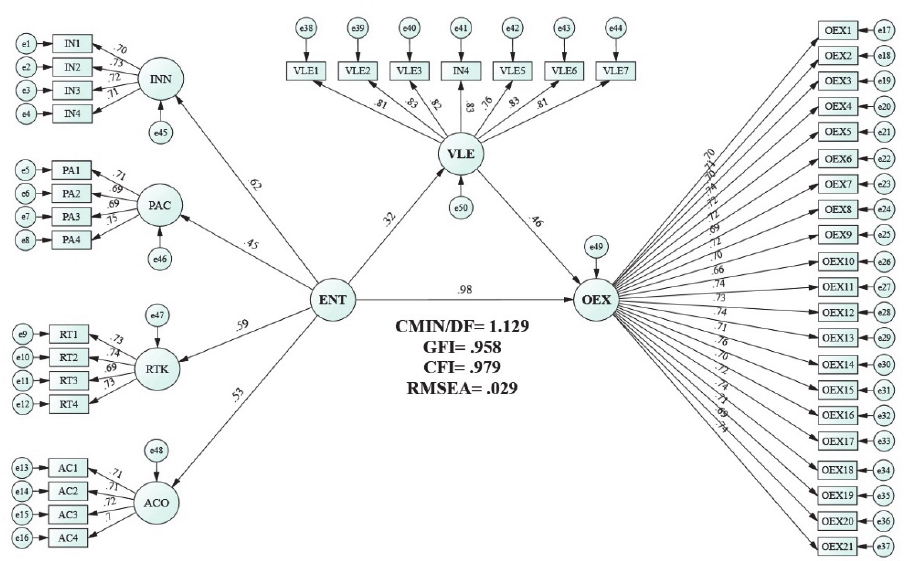
Fig. 4 . Structural equation modeling to test the mediating impact of visionary leadership between entrepreneurship and or- ganizational